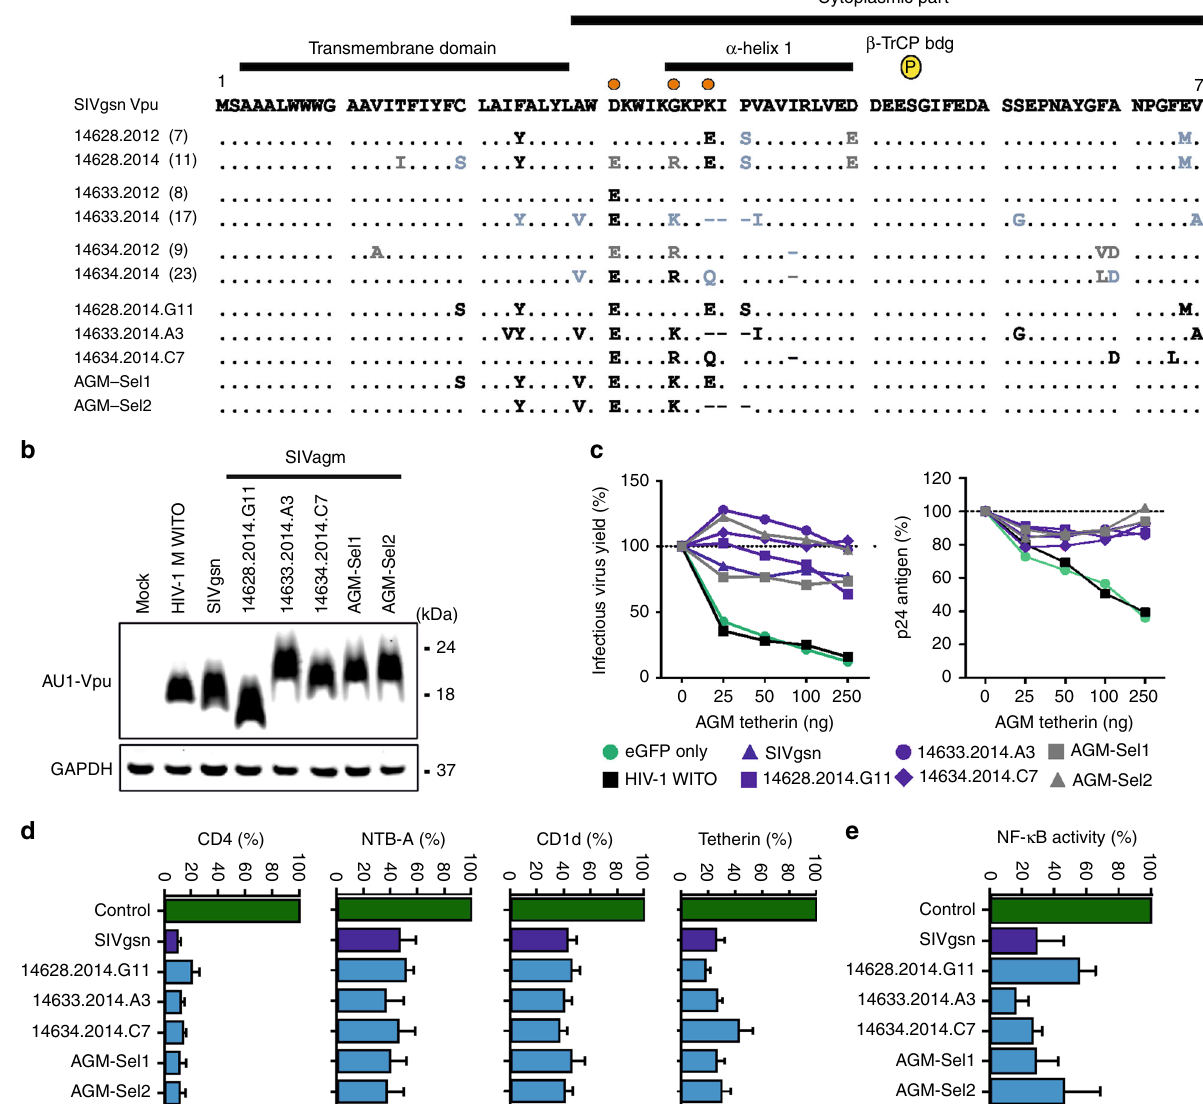
Fig. 4 Maintenance of HIV-1-like Vpu function in GU1N infected AGMs. a Alignment of Vpu sequences derived from GU1N-infected AGMs at 121 (2012) and 223 wpi (2014) and primary or synthetic (Sel1 and Sel2) Vpus chosen for functional analysis. Orange dots highlight mutations found in all three AGMs. Dashes indicate gaps introduced to optimize the alignment. Numbers specify the animal, year of plasma isolation, and number of the respective Vpu sequences. Black indicates changes in all, blue in ≥ 50% and gray in at least two sequences. b Expression of AU1-tagged SIVgsn Vpu proteins. HEK293T cells were transfected with expression plasmids encoding the indicated AU1-tagged Vpus and eGFP. Mock transfected cells were used as negative controls. GAPDH expression levels were analyzed to control for loading. c Infectious virus (left) and p24 antigen (right) yield from HEK293T cells cotransfected with an HIV-1 NL4-3 Δ vpu construct and vectors expressing the indicated vpu alleles in combination with increasing amounts of plasmids expressing AGM tetherin. Shown are average values derived from three experiments relative to those obtained in the absence of tetherin (100%). d Vpu- dependent reduction of CD4, NTB-A, CD1d, and AGM tetherin surface expression in HEK293T cells relative to those measured in cells transfected with the eGFP only control vector. Values in panels d and e represent mean ( + SEM) derived from three independent experiments. e AGM-derived Vpu proteins suppress NF- κ B activity. The effects were measured as described in the legend to Fig.